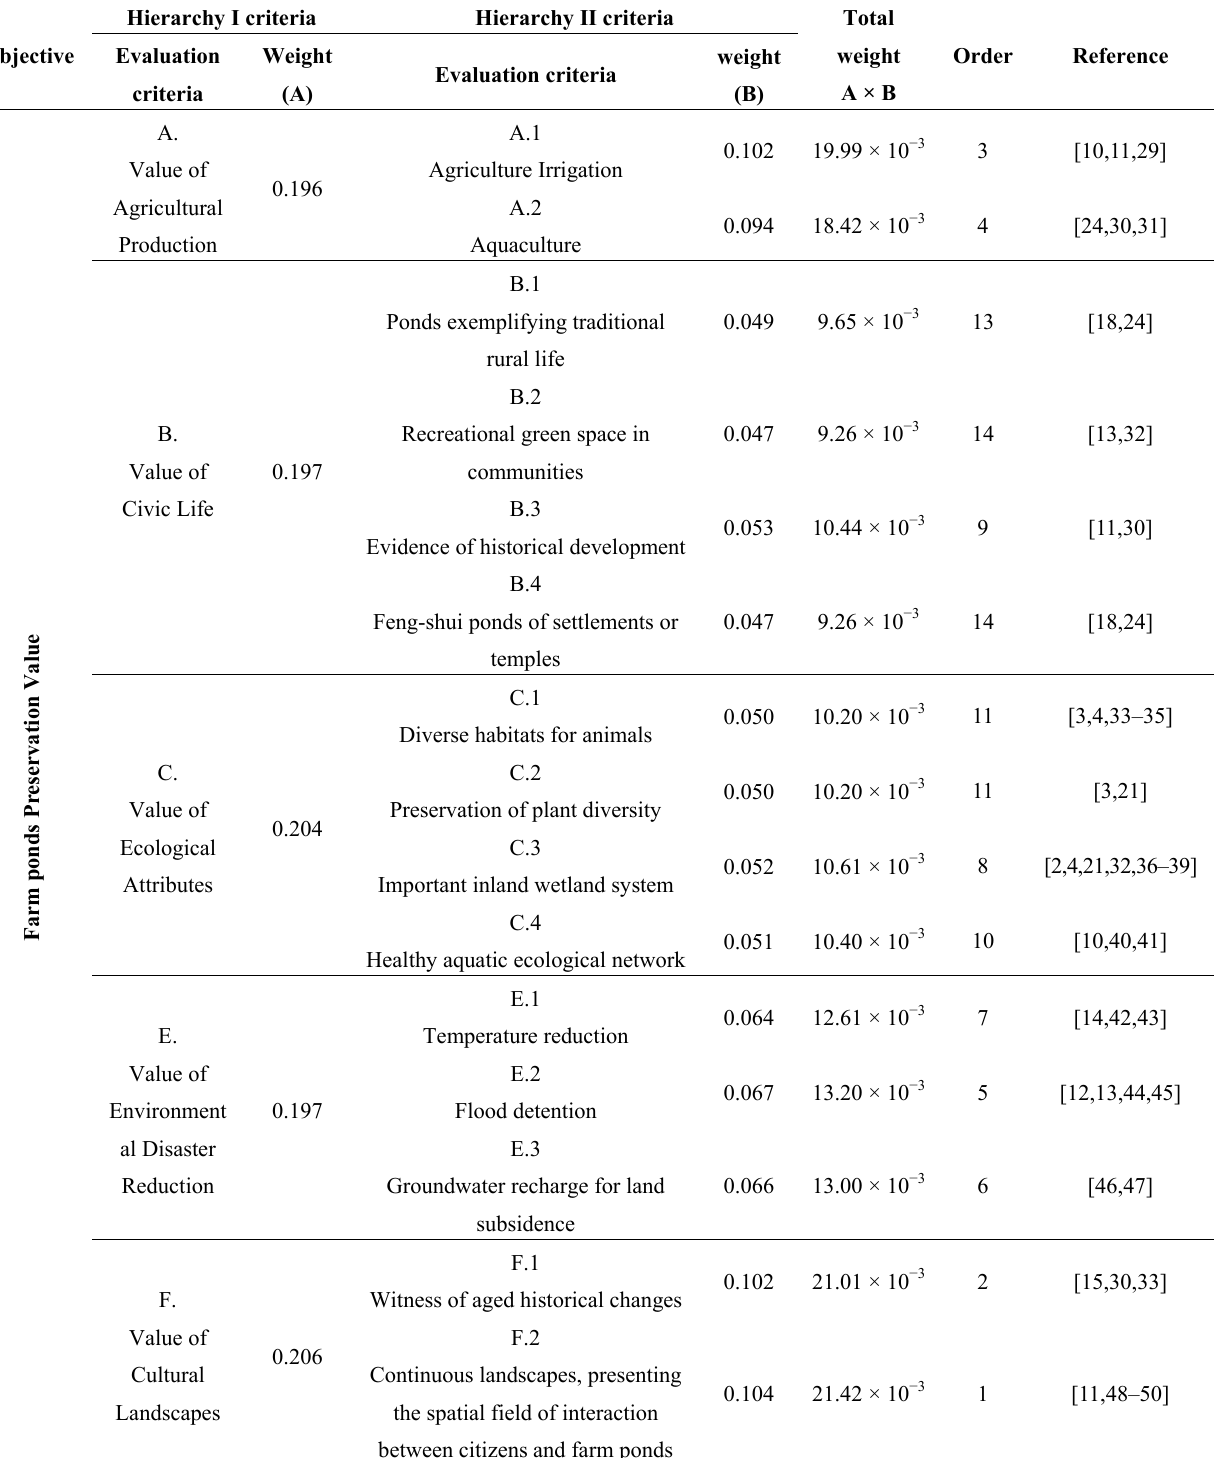
Table 1. Weights of preservation value evaluation of farm